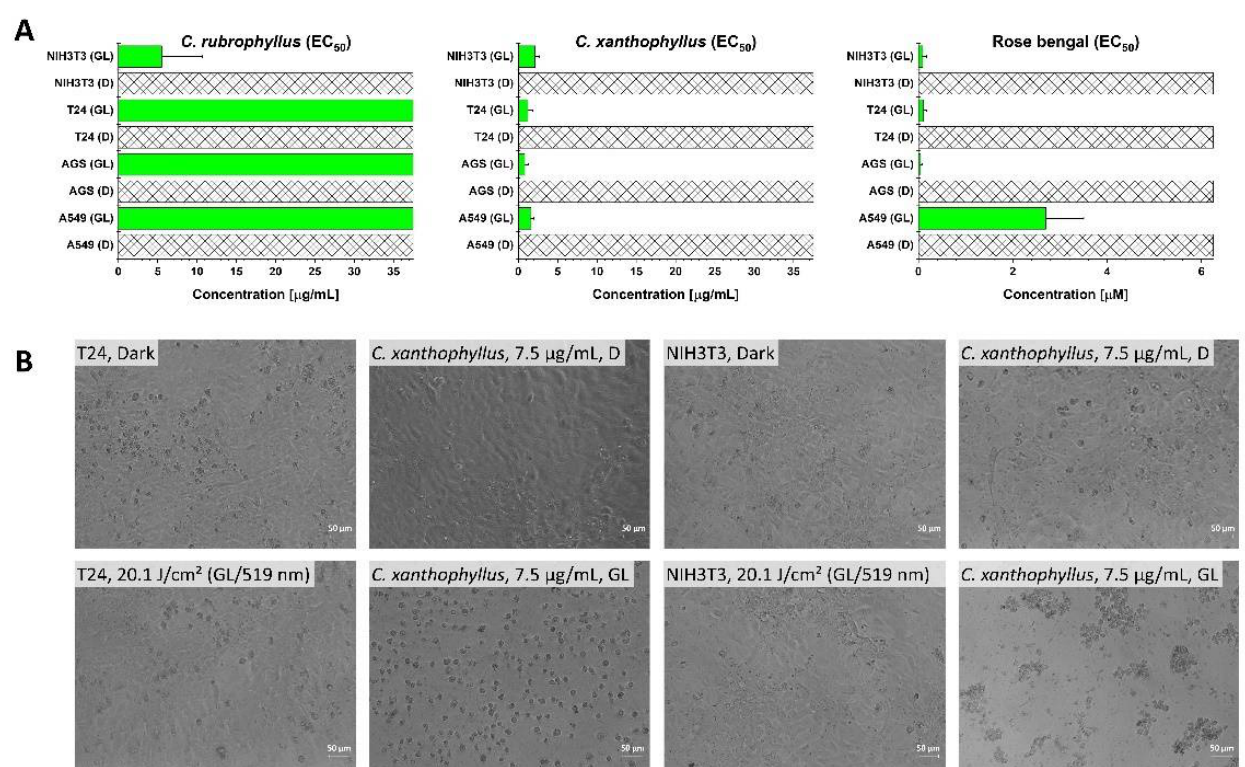
Figure 4. Results of the (photo)cytotoxicity assay employing green light (λ = 519 nm, 20.1 J cm −2 ). ( A ) (Photo)cytotoxic activity of the acetone extracts of C. rubrophyllus , C. xanthophyllus , and rose bengal against the three cancer cell lines T24, AGS, and A549 as well as against the non-malignant NIH3T3 cell line. Bars: EC 50 value in µg/mL/µM with the respective confidence interval (95%). ( B ) Micrographs (200× magnification) of cells of the T24 and NIH3T3 cell lines treated (24 h) with the acetone extract of C. xanthophyllus (7.5 µg/mL). The upper line of pictures shows treated cells in the dark, the lower after irradiation with green light (519 nm, 20.1 J/cm 2 ).